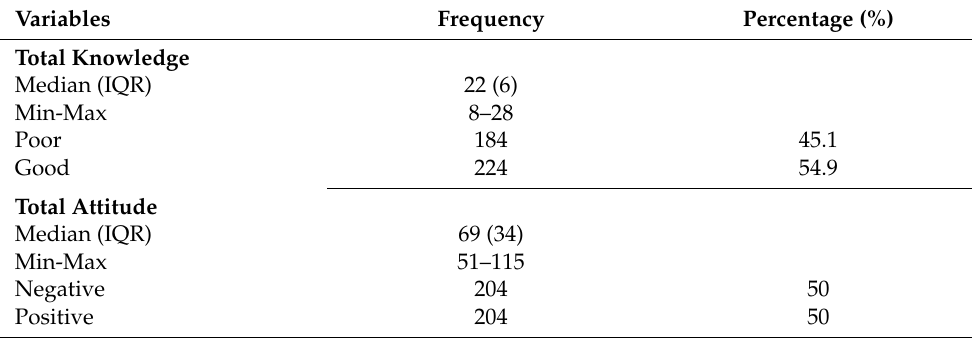
Table 4. Distribution of total knowledge and attitude of medication